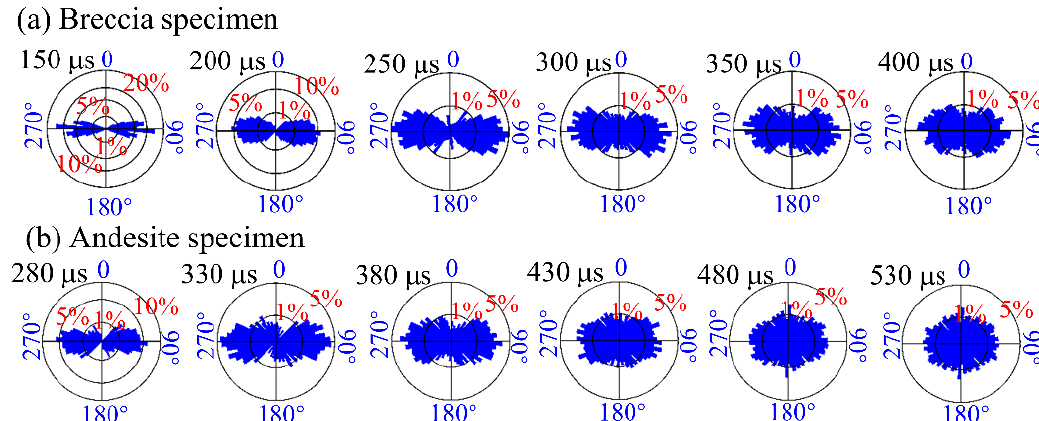
Table 1. The fitted parameters of the Gaussian function.